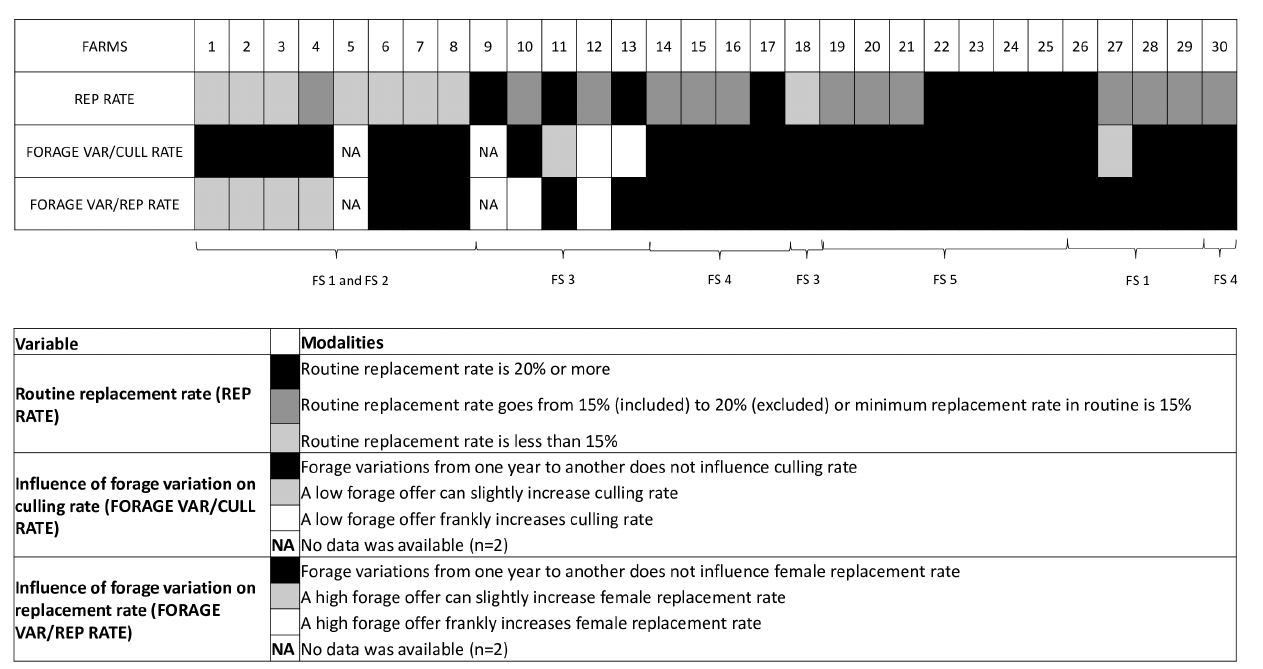
Figure 3. Adjustment of the flock demography according to the inter-annual variations of the fodder offers in Corsica (C1,